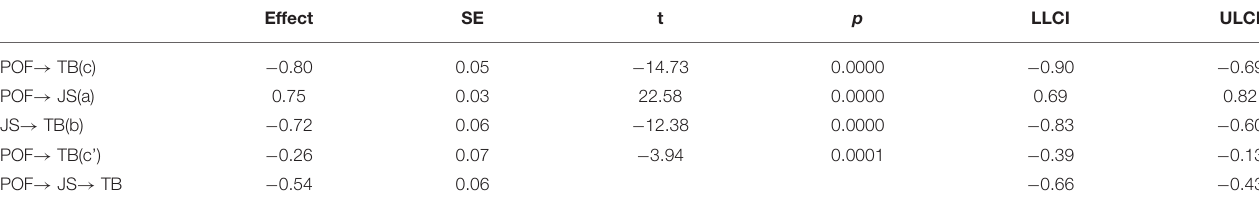
TABLE 4 | Mediating effect of job satisfaction.